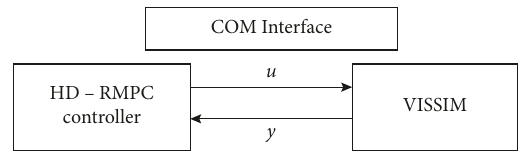
Figure 5: Interaction between HD-RMPC controller and the microscopic traffic simulator